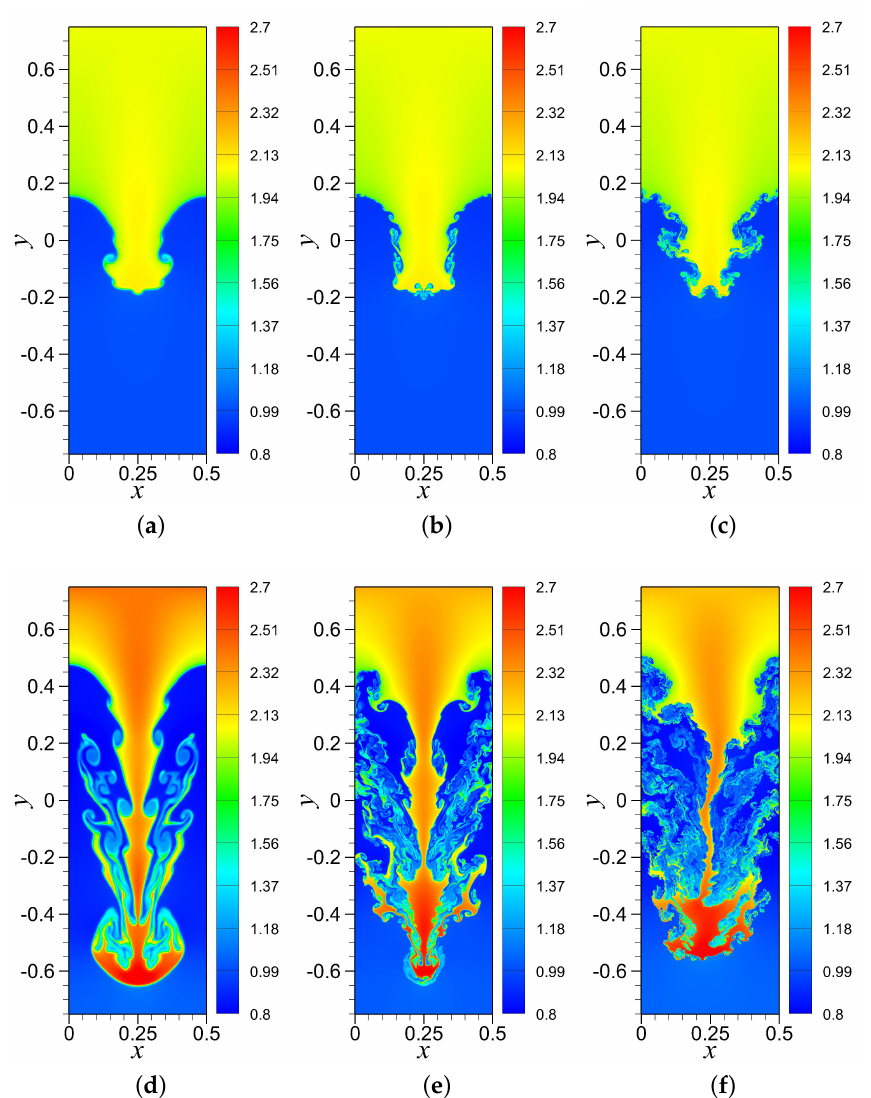
Figure 14. Time evolution of density field for the RTI problem with single-mode perturbation for different coarse grid resolutions using ILES-Rusanov scheme: ( a ) ILES-Rusanov with 256 × 768 resolution at t = 2.7; ( b ) ILES-Rusanov with 1024 × 3072 resolution at t = 2.7; and ( c ) ILES-Rusanov with 4096 × 12288 resolution at t = 2.7; ( d ) ILES-Rusanov with 256 × 768 resolution at t = 4.5; ( e ) ILES-Rusanov with 1024 × 3072 resolution at t = 4.5; and ( f ) ILES-Rusanov with 4096 × 12288 resolution at t = 4.5. The gravity is directed in a vertically downward